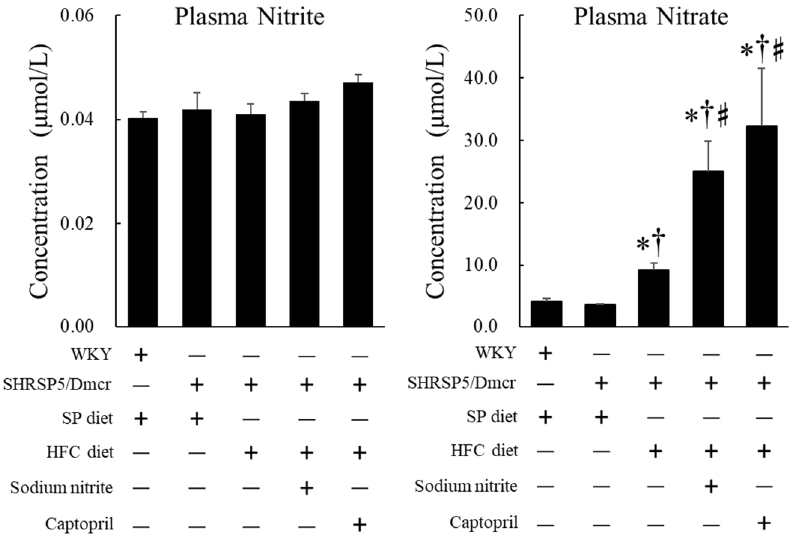
Figure 8. Effects of nitrite and captopril supplementation on the plasma levels of NOx in the rat nonalcoholic steatohepatitis model. Values represent mean ± SE ( n = 6), * p < 0.05 vs. WKY + SP diet group, † p < 0.05 vs. SHRSP5/Dmcr + SP diet group, ♯ p < 0.05 vs. SHRSP5/Dmcr + HFC diet group. NOx, nitrite, and nitrate.